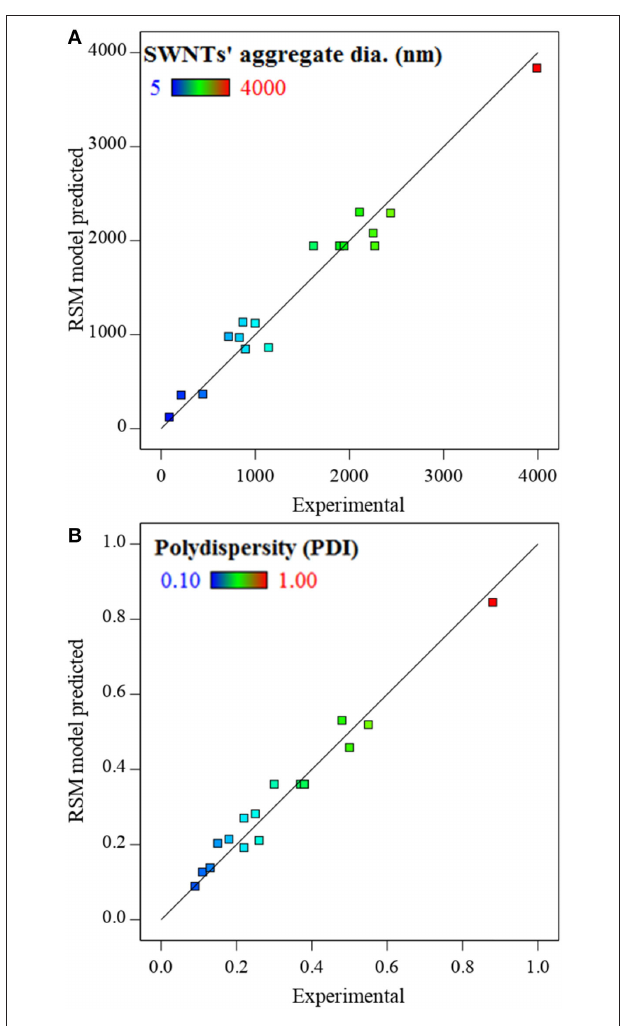
FIGURE 2 | RSM model predicted vs. experimentally observed values of SWNTs’ (A) aggregate diameter and (B) polydispersity. The straight line (y = x) is a reference for perfect